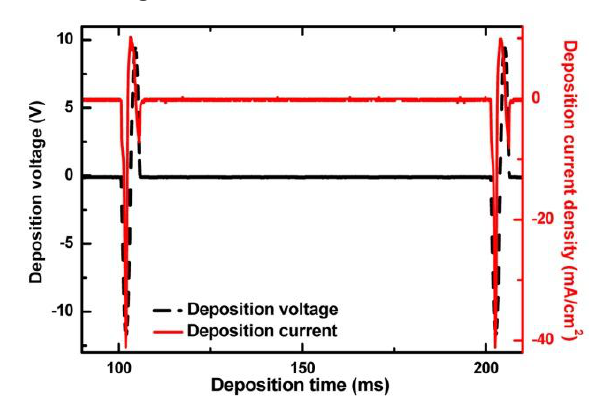
Fig. 1. The electrodeposition current density and ac pulse voltage with the reduction/oxidation time of 2.4 ms, off time of96msand maximum reduction current density of 40 mA/cm 2